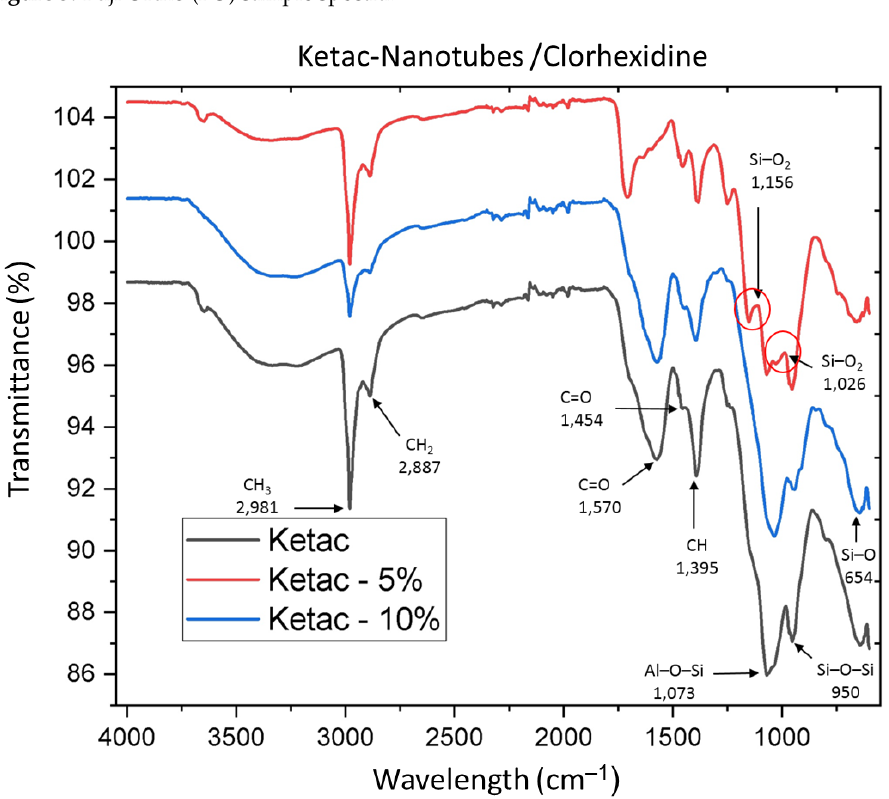
Figure 4. Fuji Ortho sample spectra.